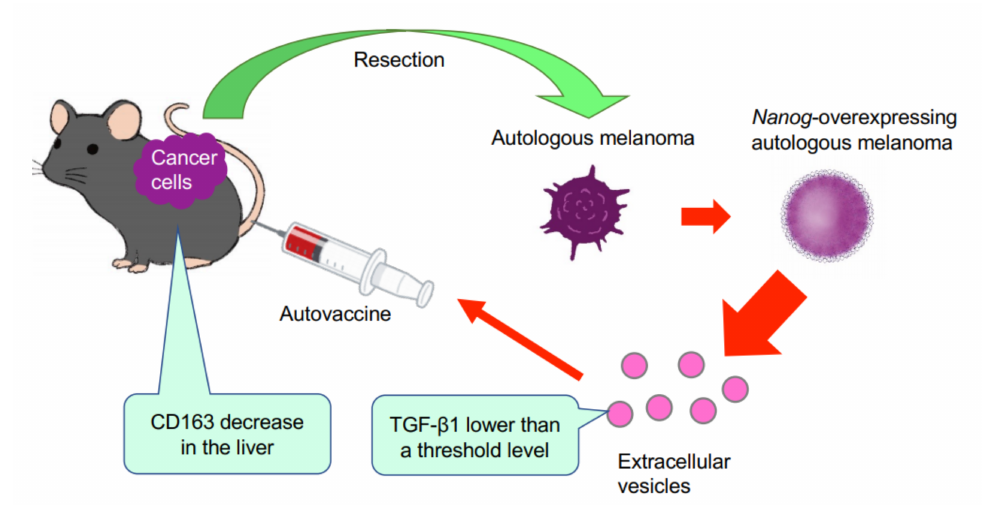
Figure 6. Concept of autovaccine using Nanog + F10-EVs. F10 cells are resected from primary melanoma. F10 cell line is genetically modified to Nanog + F10. EVs are separated from Nanog + F10 cells and administered into the mouse to acquire metastasis-suppressive